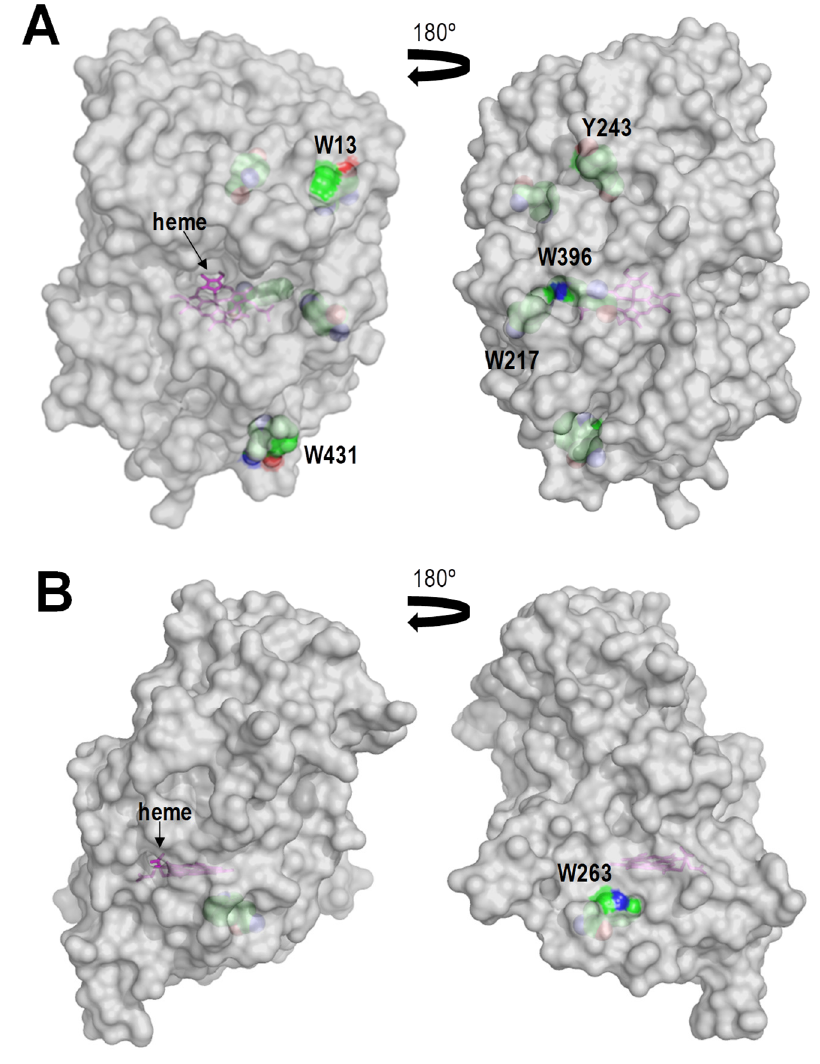
Figure 5. Two views of semi-transparent surfaces of Asp DyP2 ( A ) and Tcu DyP ( B ) showing the heme (pink sticks) access-channel and several tryptophan and tyrosine residues (CPK-colored van der Waals spheres) located near the protein surface, including Asp DyP2 Trp13, Trp217, Trp396, Trp431 and Tyr243, and Tcu DyP Trp263.